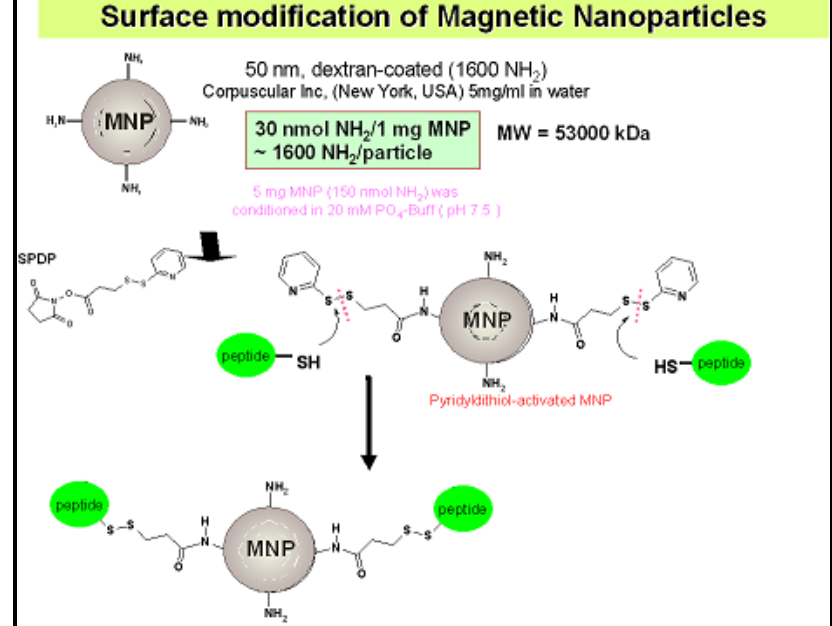
Figure(cid:9)5(cid:9)(B)(cid:9)